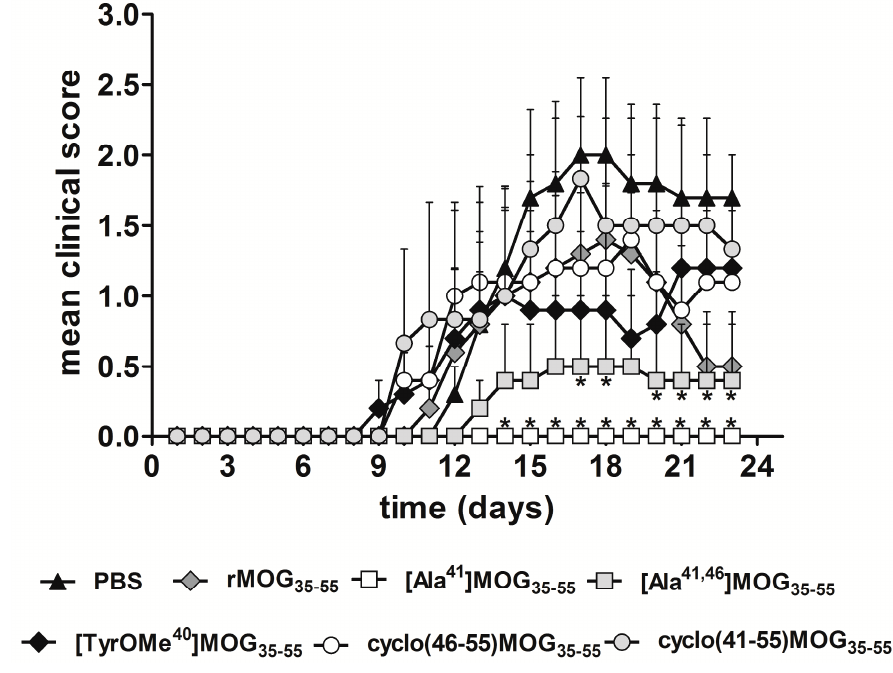
Figure 4. Co-administration of linear APLs, [Ala 41,46 ]MOG 35–55 and [Ala 41 ]MOG 35–55 , ameliorate the clinical symptoms of rat MOG 35–55 -induced EAE in C57BL/6 mice. Mean clinical scores of MOG-EAE are shown for all groups of mice against time ( n = 3 for the cyclo (41–55) MOG 35–55 and n = 5 for other groups). Statistical significance after pair-wise comparisons (using Student’s t test) of each experimental group with the non-vaccinated control (PBS) group is shown ( * p < 0.05).